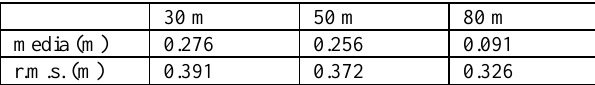
Table 4. Statistical results of trees